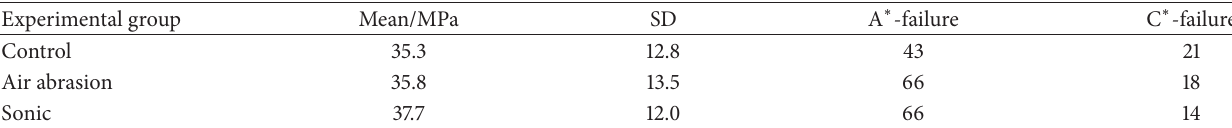
Table 2: Microtensile bond strength values in MPa obtained for the different experimental groups and number of adhesive and cohesive